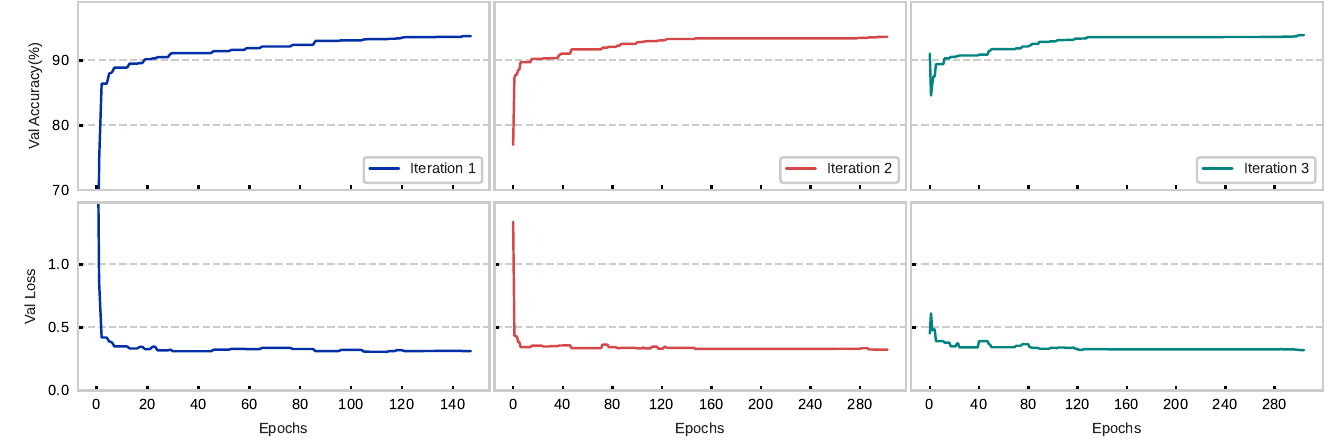
Figure 4. Fine-tuning details of ResNet110 on the Cifar10 with 1% ACC D . Three iterations are shown from left to right. Only the data when the best accuracy was updated is presented.